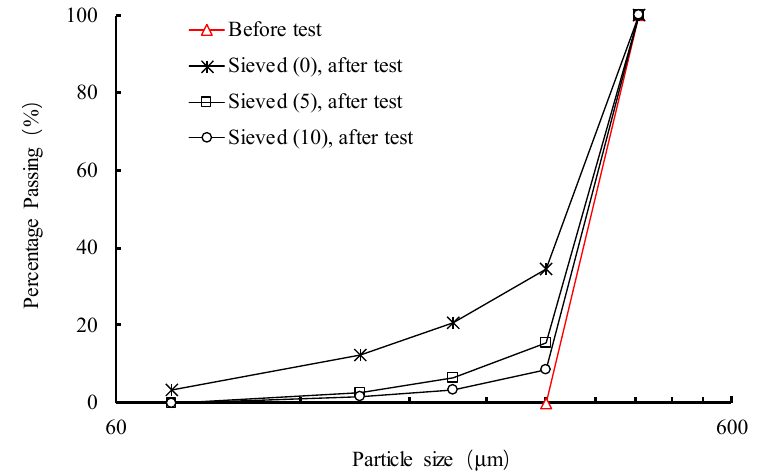
Figure 5. Particle size distribution curves of the test materials before and after the compression tests.